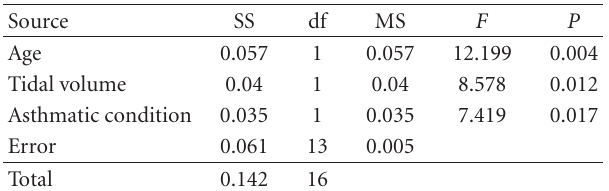
Table 5: Analysis of covariance for total deposited fraction by asthmatic condition.